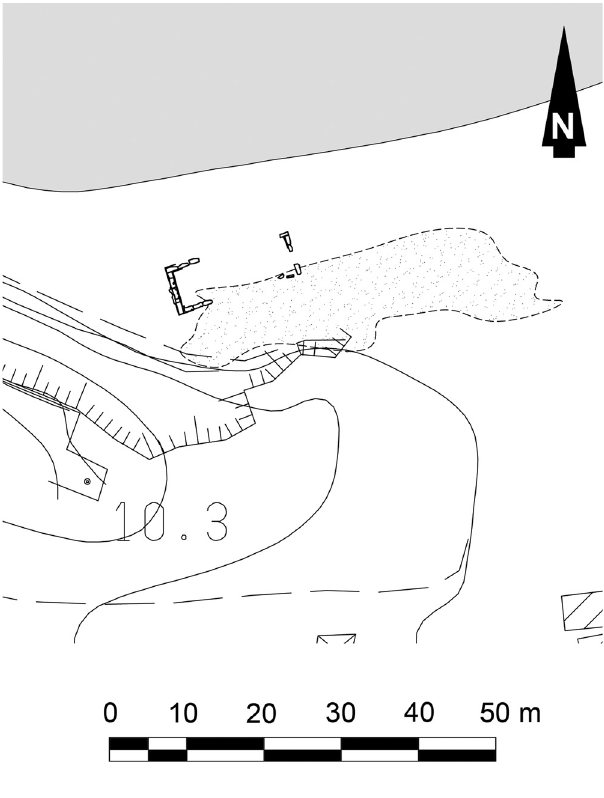
Figure 6: A survey plan combining all the various documentation exercises carried out between 2010 and 2013 ( Source: Superintendence of Cultural Heritage )